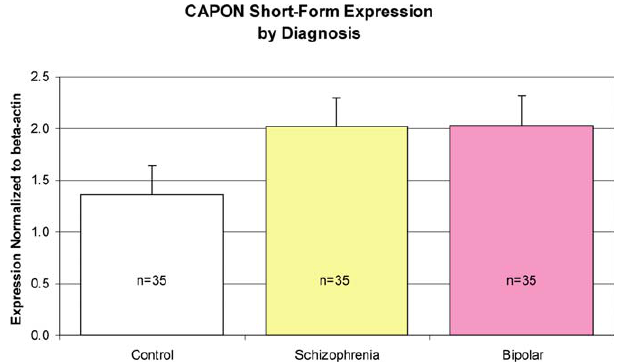
Figure 3. ACTB (Beta-Actin)–-Normalized CAPON mRNA Full-Length Expression by Diagnosis Expression levels are least squares means. Mean values per category are plotted with 95% confidence intervals. The number of individuals per sample is indicated within each bar. Level of expression does not differ significantly by diagnostic group. The mean (95% confidence interval lower bound, upper bound) for the control, schizophrenia, and bipolar groups are 1.28 (1.12, 1.45), 1.33 (1.17, 1.49), and 1.16 (0.99, 1.32), respectively. DOI: